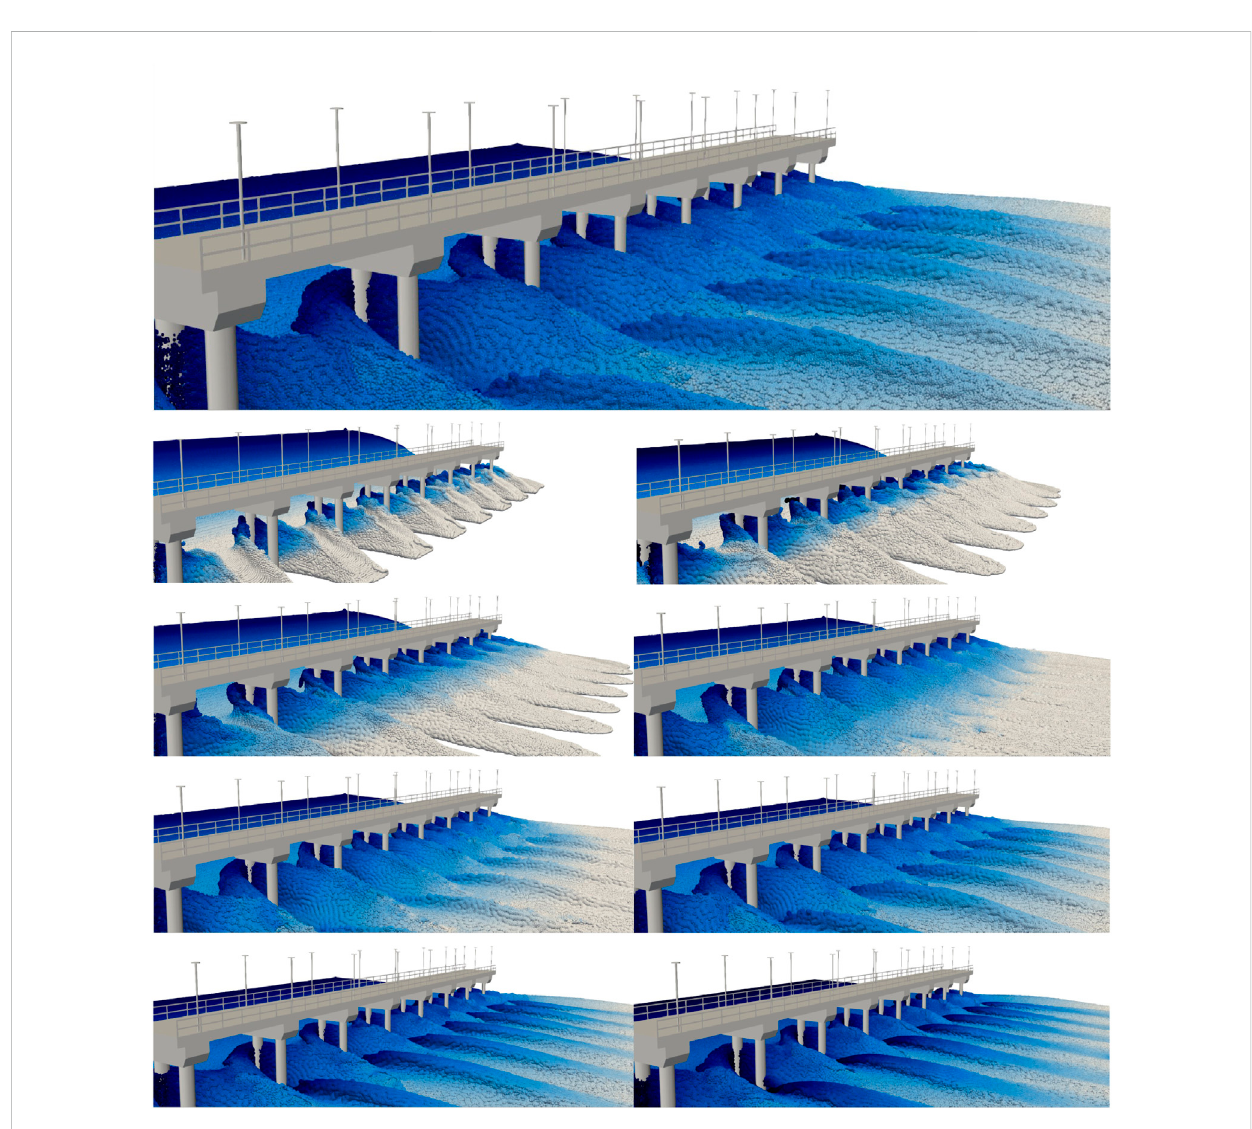
FIGURE 15 Simulation procedure of fl ood impact on